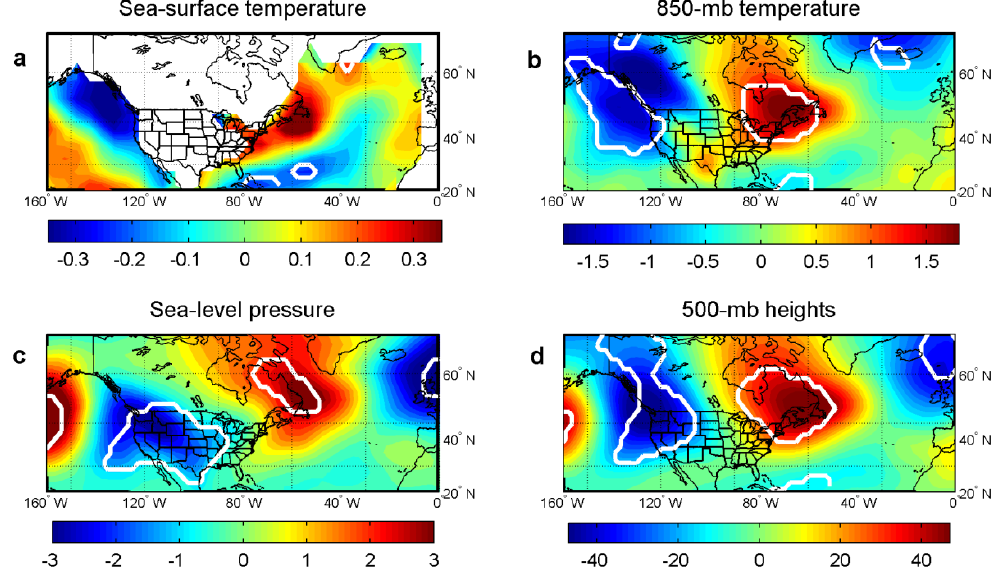
Figure 9. Composite differences between the 12 years with the greatest increase and 12 years with the greatest decrease of wintertime (NDJ) lake-level, for high-pass filtered seasonal anomalies of ( a ) SSTs; ( b ) 850-mb temperatures; ( c ) SLPs; and ( d ) 500-mb geopotential heights, for 1949–1998. Areas encompassed by white lines indicate significant differences at the 5% level.